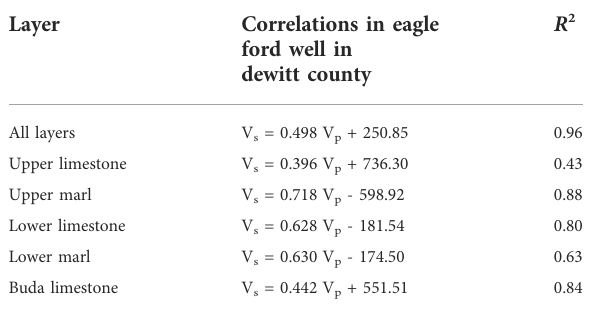
Layer Correlations in eagle